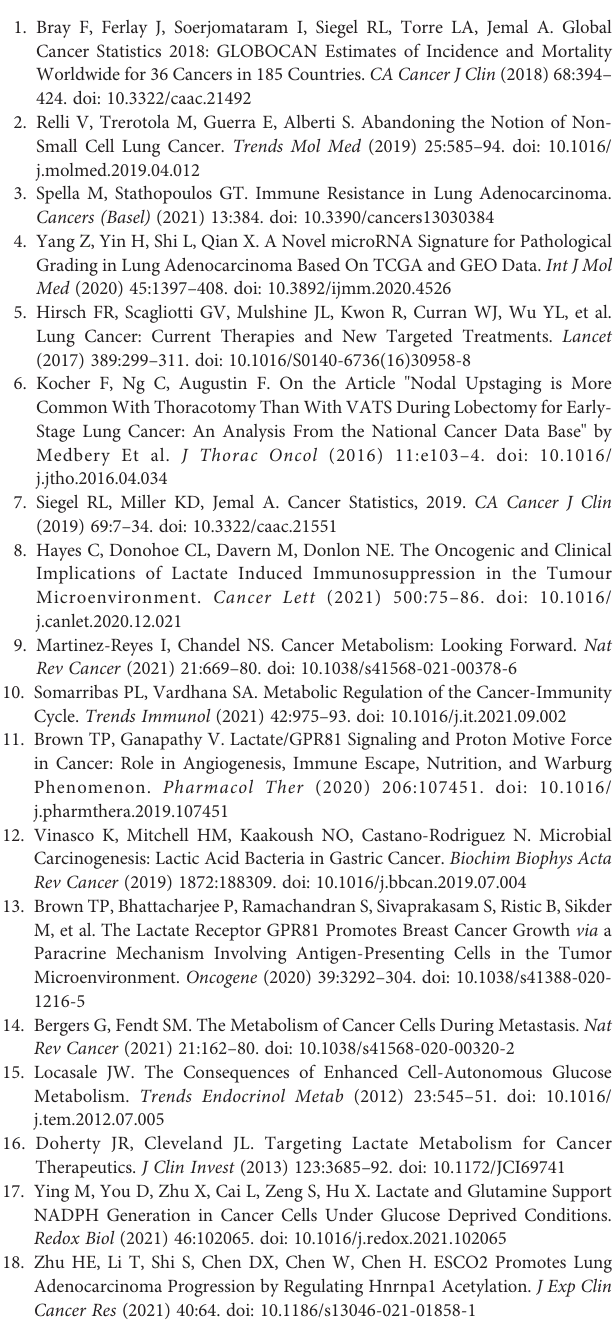
Supplementary Figure 1 | Heatmap of immune in fi ltration in low- and high-risk groups based on TIMER, ESTIMATE, ssGSEA, QUANTISEQ, MCP counter, EPIC, and CIBERSORT. Supplementary Figure 2 | Relationship between the LMR-lncRNA signature and tumor immune dysfunction, exclusion score, immunotherapy, chemotherapy, and targeted therapy. (A) Distribution of TIDE scores in high-risk